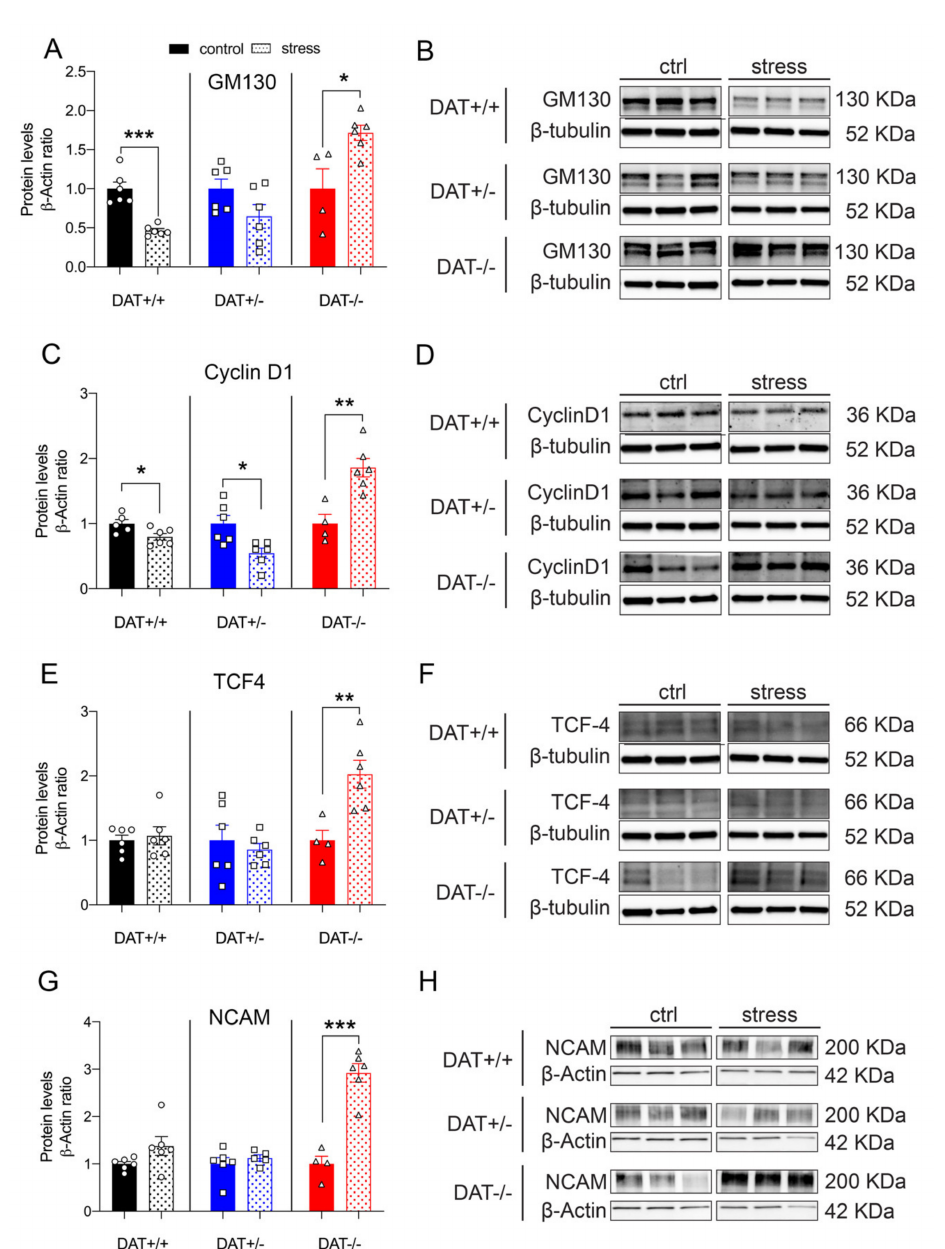
Figure 6. E ff ects of restraint stress on functional and structural components of the pituitary gland. ( A ) Exposure to restraint stress significantly reduced levels of GM130 in control rats (DAT +/+ ); however, no changes were induced in DAT +/ - rats while significant increases were found in DAT- / - rats. ( C ) Cyclin D1 protein levels were significantly reduced after stress in DAT +/+ and DAT +/ - rats; however, the e ff ects of stress in full DAT ablated rats were opposite compared to their own basal levels. Restraint stress increased ( E ) TCF4 and ( G ) N-Cadherin adhesion molecule (NCAM) protein levels in DAT- / - rats but did not alter levels in DAT +/+ or DAT +/ - rats. ( B , D , F , H ) Immunoblots from representative rats in each group are shown. For each genotype, data were expressed as relative to basal (non-stress) conditions. Data were normalized to β -tubulin or β -actin, relative to control (DAT +/+ ). Data are expressed as mean ± SEM ( n = 4–6), * p < 0.05, ** p < 0.01, *** p <